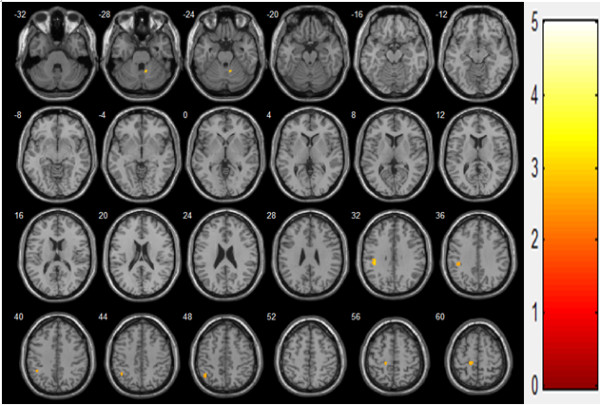
 Combined movement > FES only movement (N = 38, t(36) > 3.333,p < 0.001).